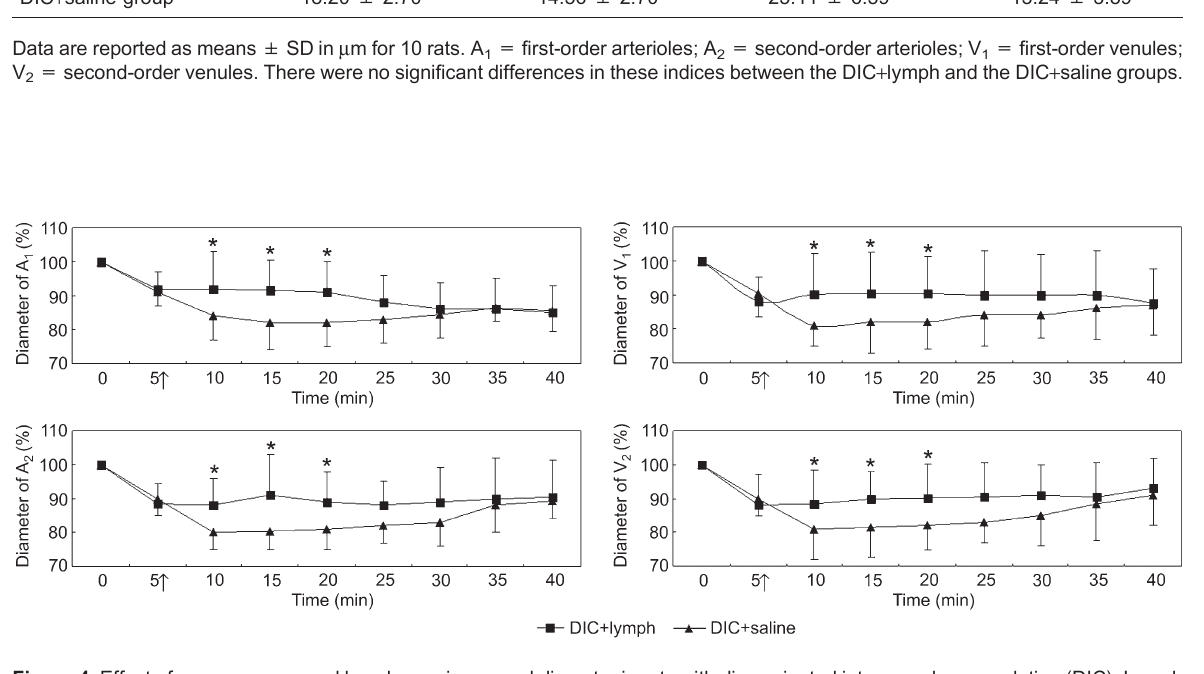
Figure 4. Effect of exogenous normal lymph on microvessel diameter in rats with disseminated intravascular coagulation (DIC). Lymph or saline was injected ( iv ) at 6 min (arrow). Data are reported as means ± SD for 10 rats. A 1 = first-order arterioles; A 2 = second- order arterioles; V 1 = first order venules; V 2 = second order venules. *P , 0.05 compared to the DIC + saline group (paired t